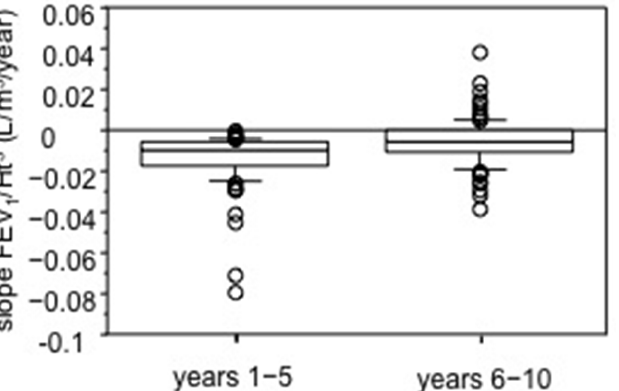
Figure 1. Slope values of relationships between height-adjusted FEV 1 and time (L/m 3 /year), sepa- rately for years 1–5 and 6–10. Bars indicate (from the bottom to the top) 10th, 25th, 50th (median), 75th and 90th percentiles. Values below 10th and above 90th percentiles are plotted as circles. A significant difference was found ( p < 0.0001, Wilcoxon test).